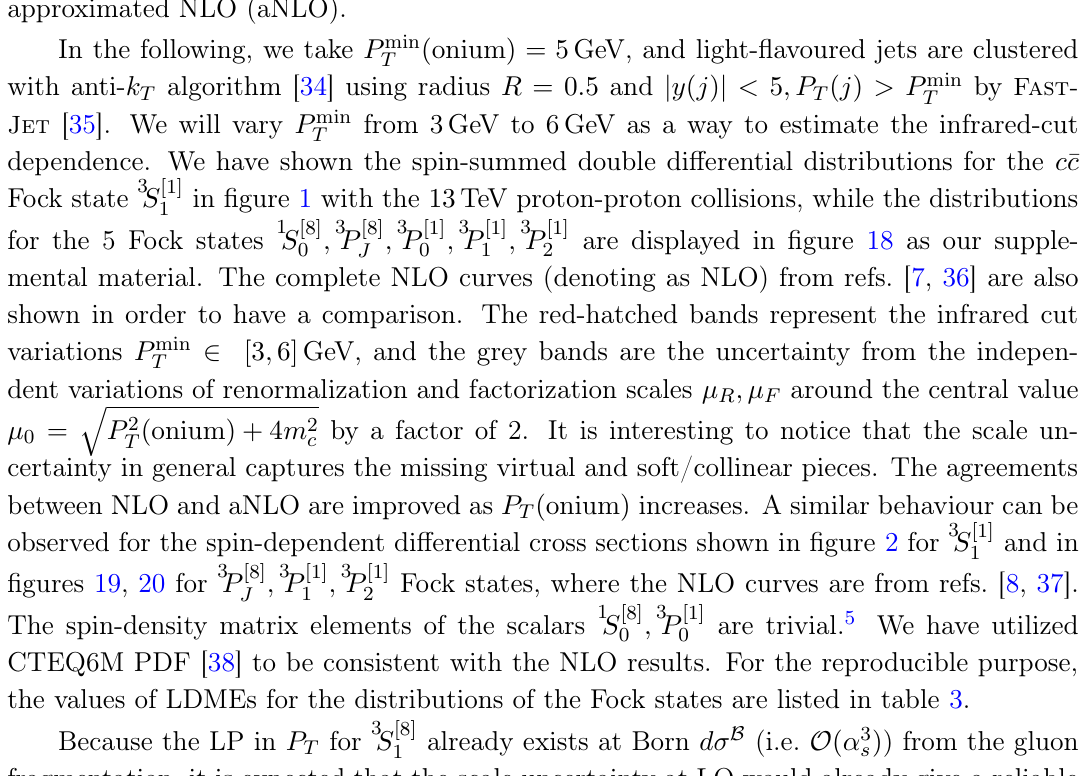
Table 3 . The values of LDMEs used in the differential distributions of various Fock states. (onium) . We call the summed results of d(cid:27) B + d(cid:27) R 0 + d(cid:27) C as approximated NLO